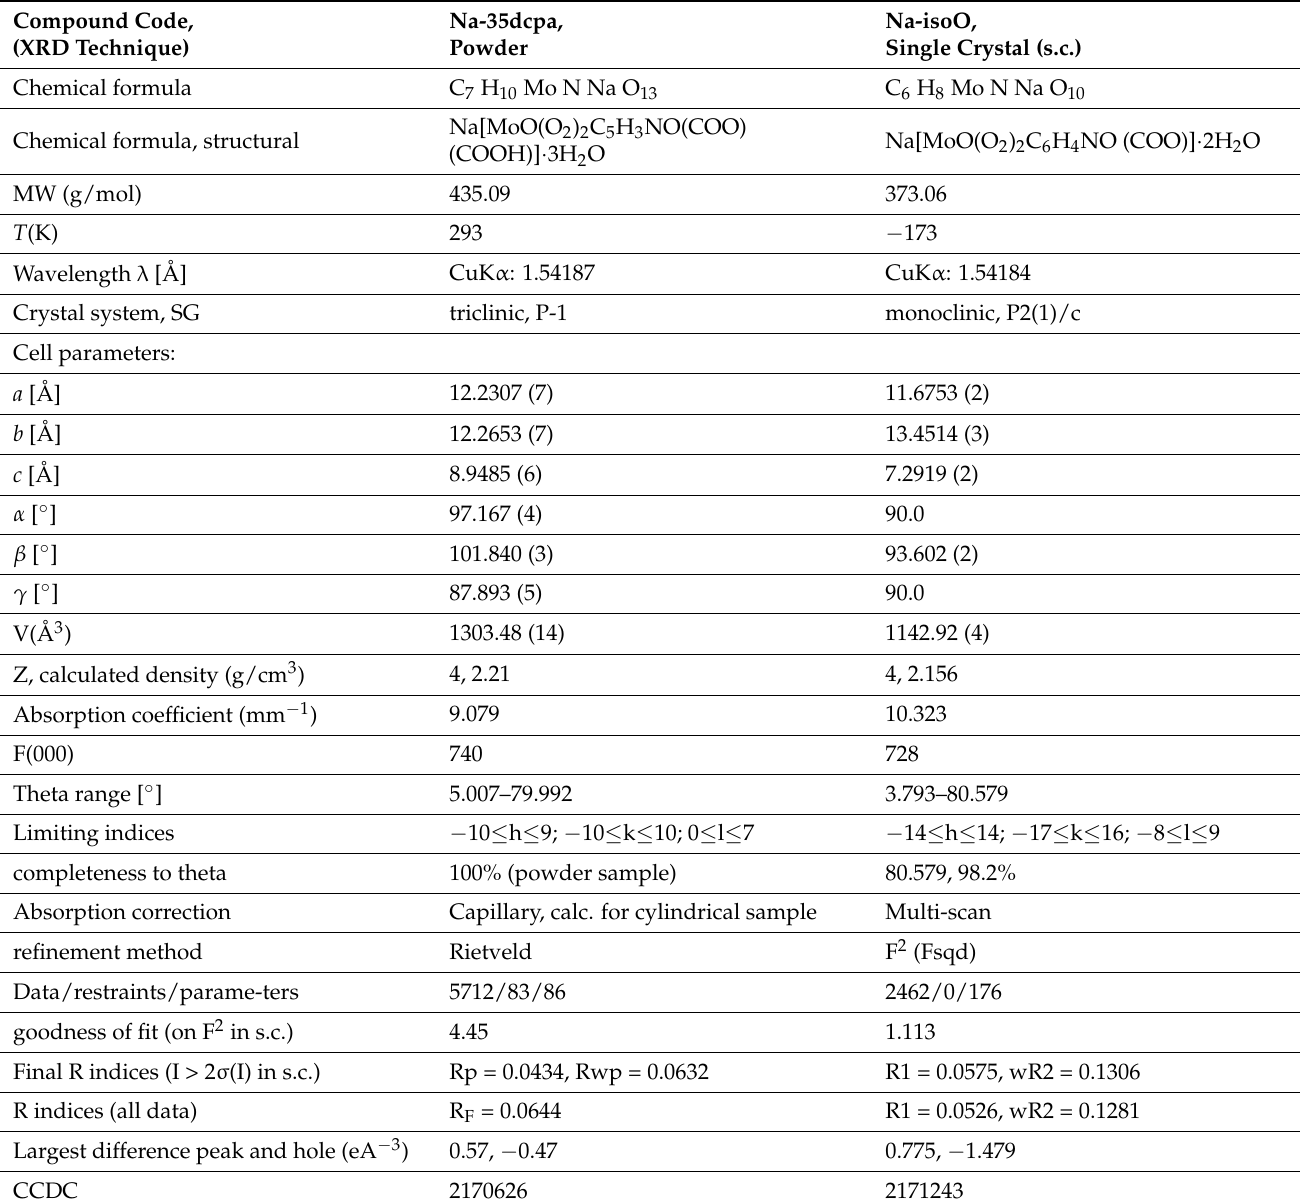
Table 1. Summary of crystal data of the investigated